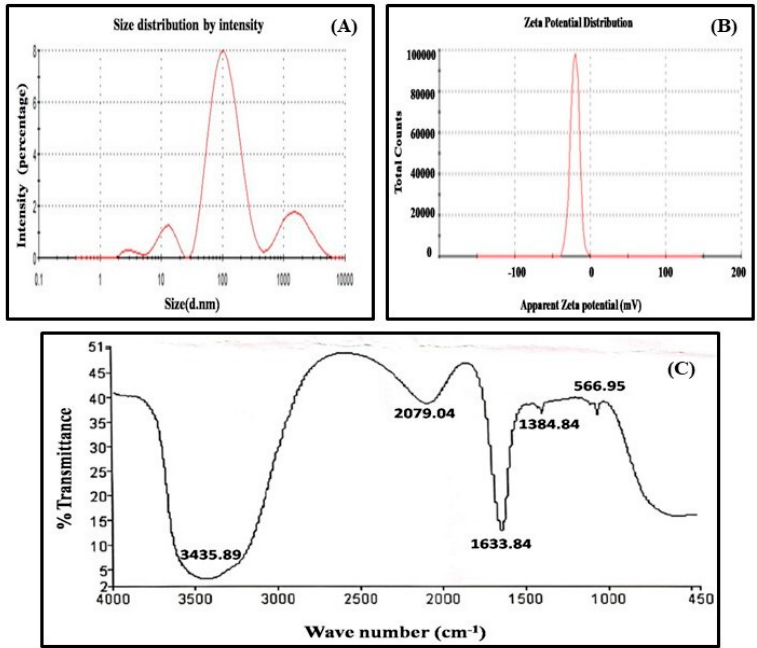
Figure 2. Characterization of AgNPs using ( A ) dynamic light scattering (size 22.25 d.nm), ( B ) zeta potential ( − 20.3 mv), ( C ) fourier transform infrared spectroscopy.